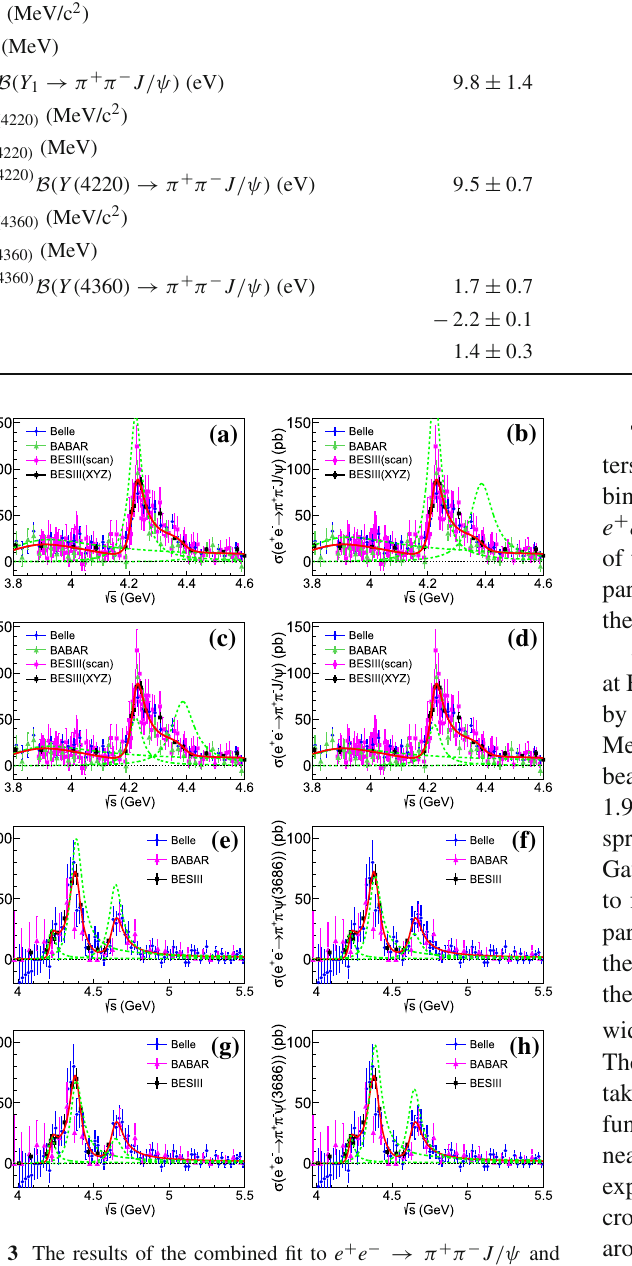
Fig. 3 The results of the combined fit to e + e − → π + π − J /ψ and e + e − → π + π − ψ( 3686 ) . Four solutions are shown in plots ( a ), ( b ), ( c ), ( d ) for e + e − → π + π − J /ψ and ( e ), ( f ), ( g ), ( h ) for e + e − → π + π − ψ( 3686 ) . The solid red curves show the best fits, and the dashed green ones are individual components